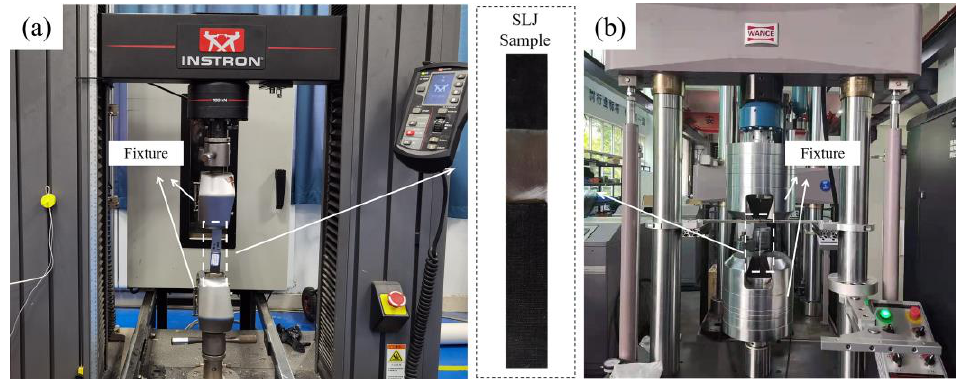
Figure 3. Testing equipment: ( a ) universal testing machine and ( b ) electro-hydraulic servo fatigue testing machine.